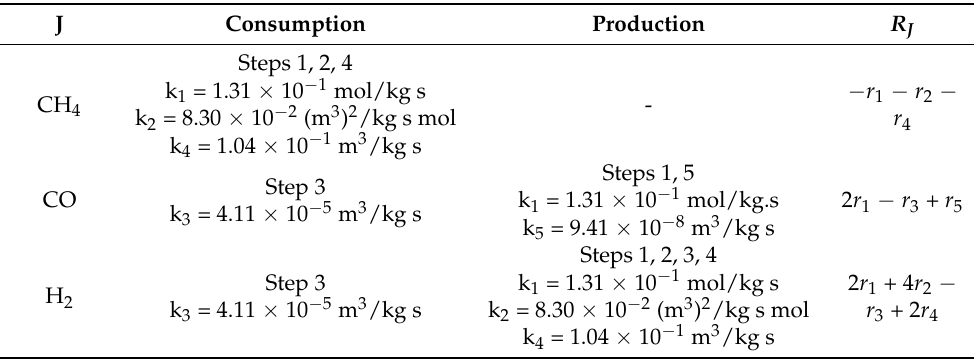
Table 7. Reaction rates of the autothermal reform of methane. Conditions: Ni(4.8 wt.%)/ γ -Al 2 O 3 , 1023 K, 1.0 bar [6].